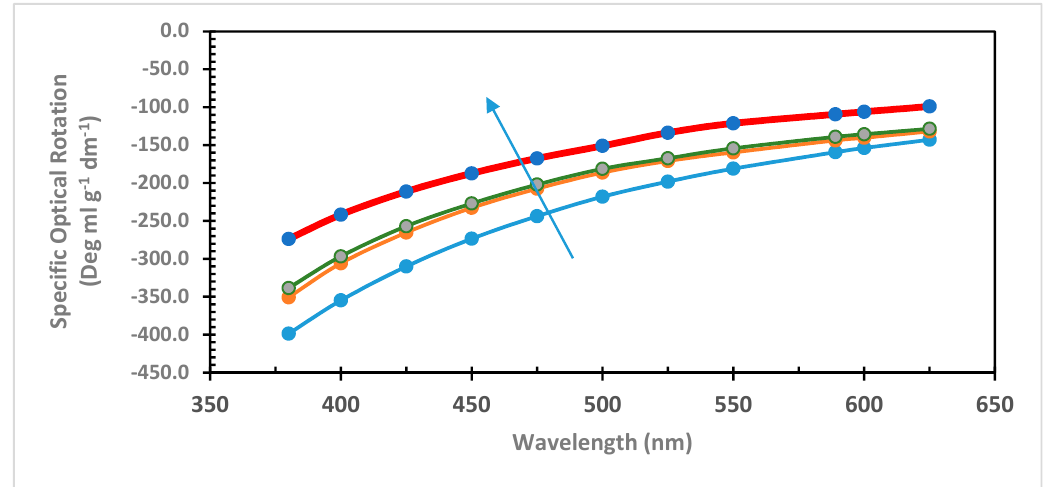
Figure 3. Optical rotatory dispersion (ORD) of pristine PLLA in CHCl 3 (blue line and dots); PLLA heated 8 h in chloroben- zene (orange line and dots); PLLA heated 4 h in o-dichlorobenzene (green line and grey dots); PLLA heated 28 h in 1,2,4-trichlorobenzene (red line and blue dots). The arrow over the ORD curves indicates the PLLA racemization